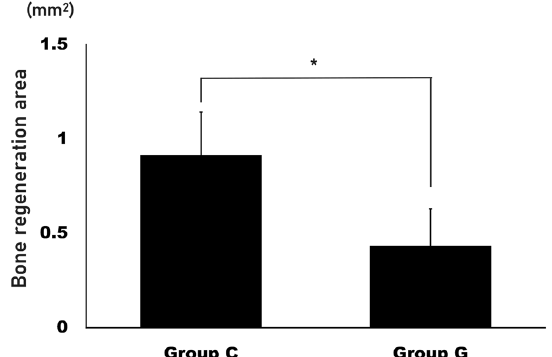
Fig. 4 Histological analysis of bone regeneration area. Based on the defect size, the area of bone regeneration was measured and compared between the collagen group (group C) and the gelatin group (group G). The area of bone regeneration in group C was significantly larger than in group G (* P =